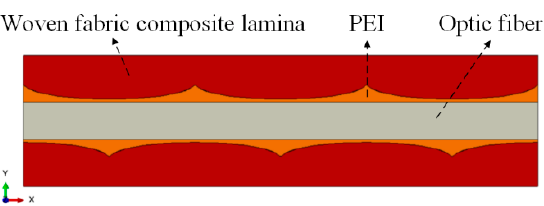
Figure A1. Representative 2D sandwich structure with an embedded optical fiber.